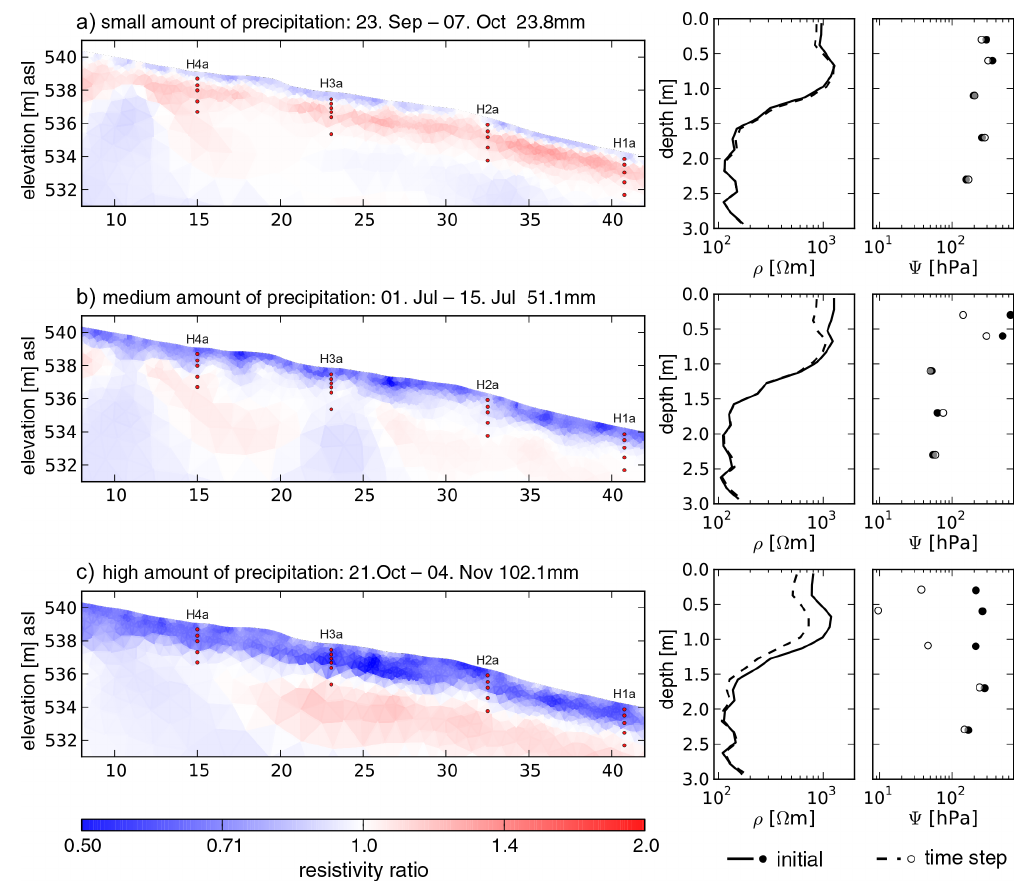
Figure 10. Ratio between subsequent resistivity (first column), median resistivity as a function of depth (second column) and median soil water tension (third column) for three exemplary precipitation responses: (a) small amount, (b) medium amount and (c) high